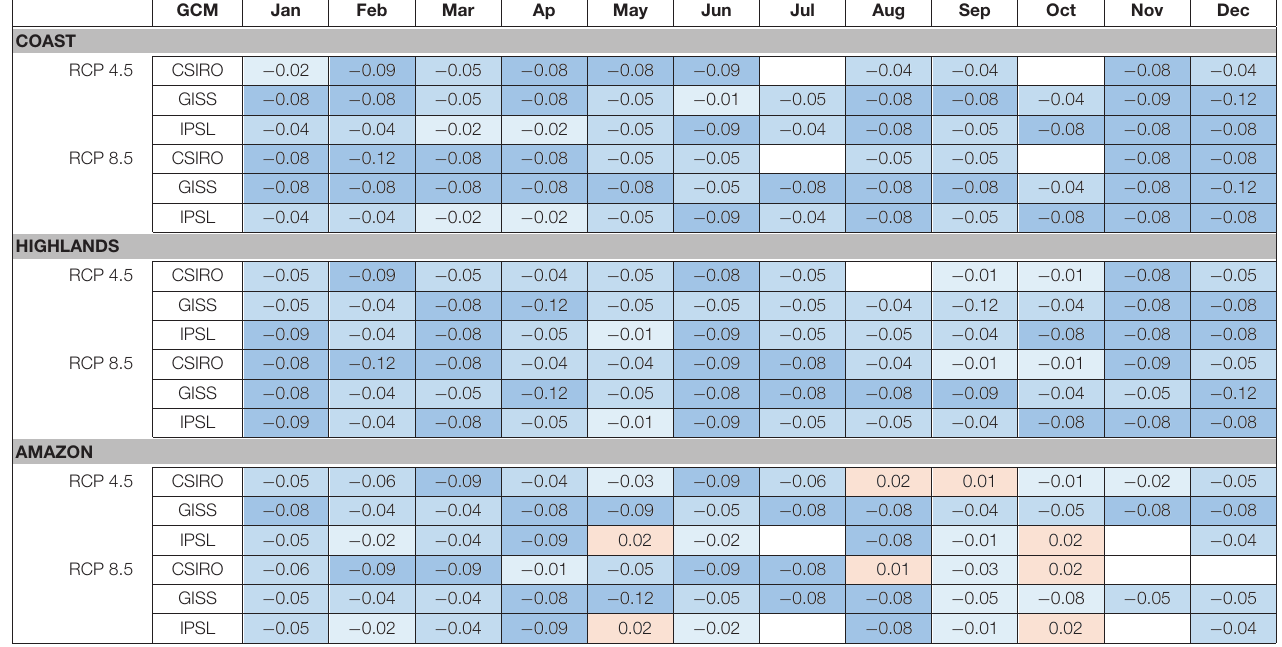
TABLE 5 | Monthly changes of drought probablity for moderate droughts.